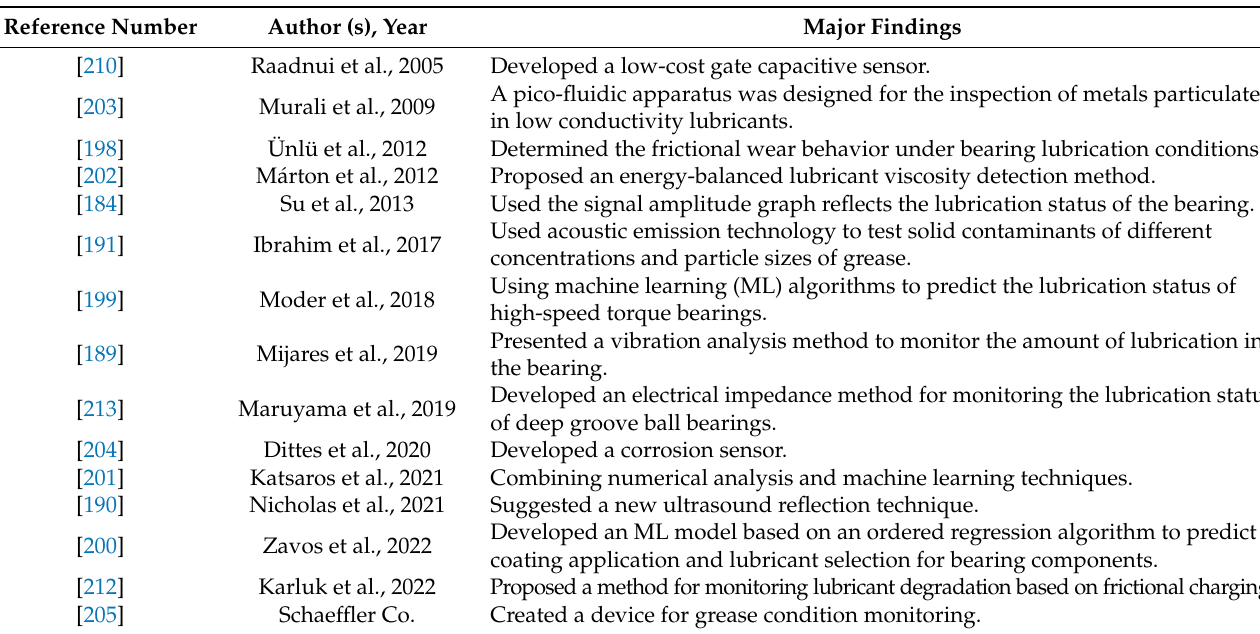
Table 8. Summary of research on wind turbine bearing lubrication monitoring